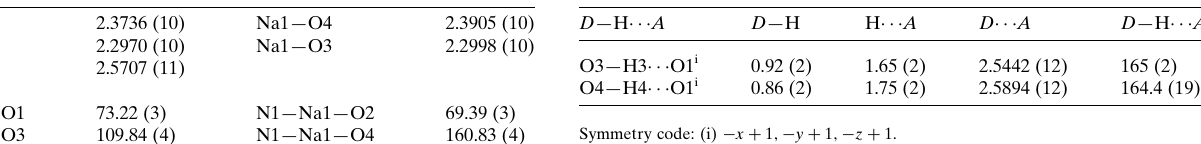
Table 3 Hydrogen-bond geometry (A˚ , (cid:4) ) for 2 .